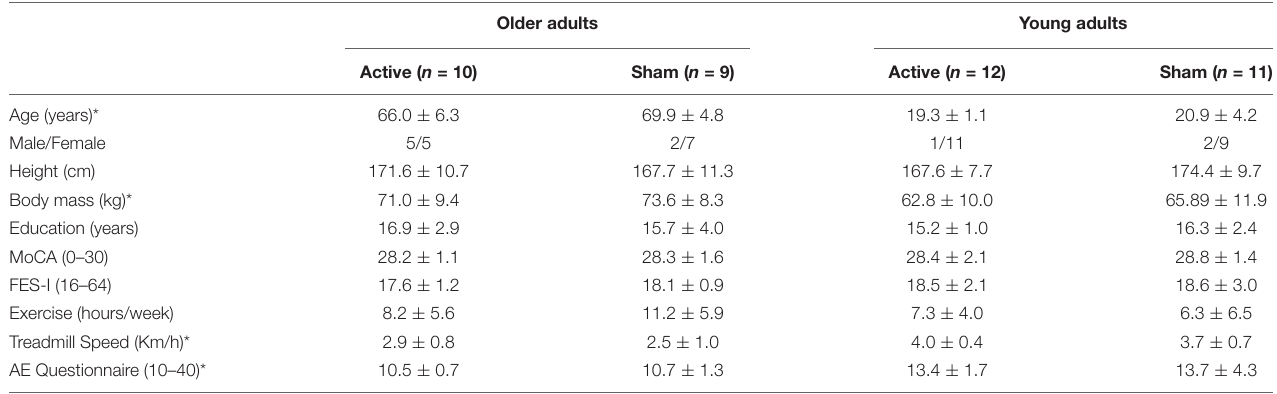
TABLE 1 | Participant characteristics (Mean ±